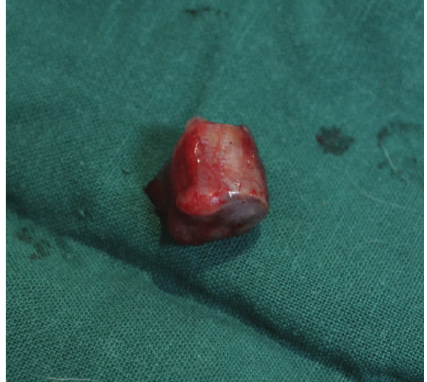
Figure 2: Macroscopic views of nHAC/PLA